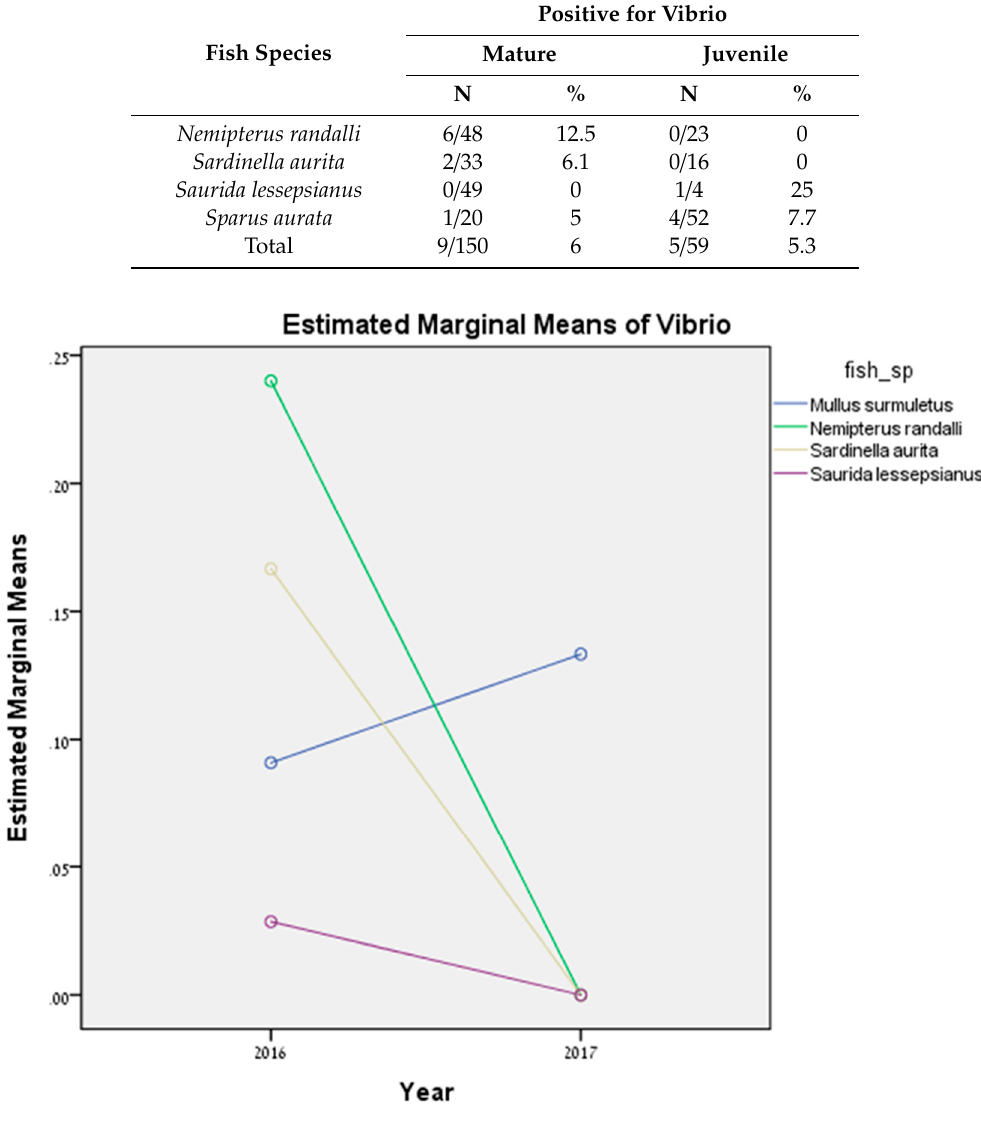
Figure 2. Vibrio sp. prevalence interaction between fish species and between years. Table 5. Vibrio sp. prevalence in wild fish species from the Mediterranean Sea. The results are based on the PCR targeting 16S rRNA segments. Positive results refer to one or more isolated tissue.